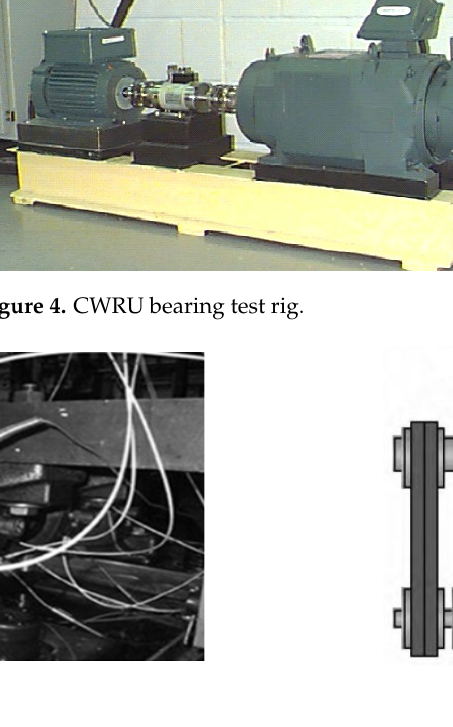
Figure 4. CWRU bearing test rig.